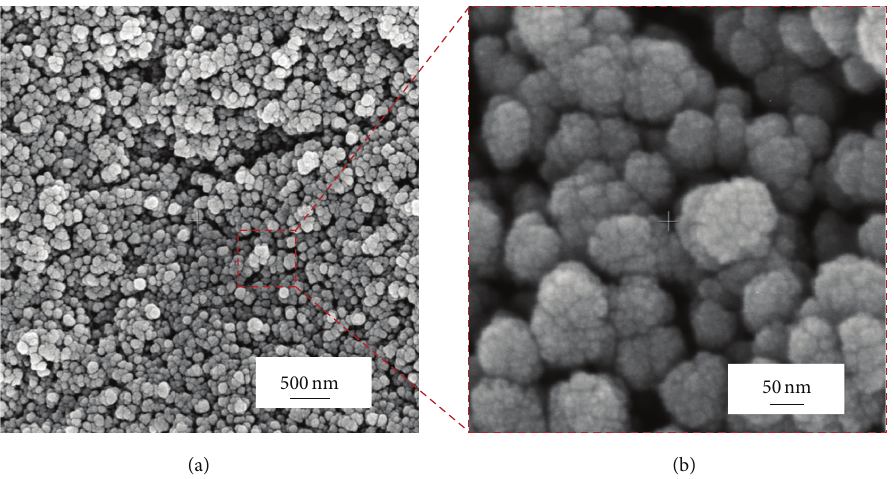
Figure 6: SEM images of aerogel materials derived from CSi-4-1 at (a) 50,000x and (b) 400,000x magnifications.